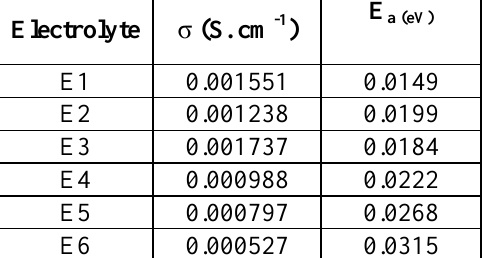
Table 2: Conductivity at ambient temperature and activation energy (E polymer